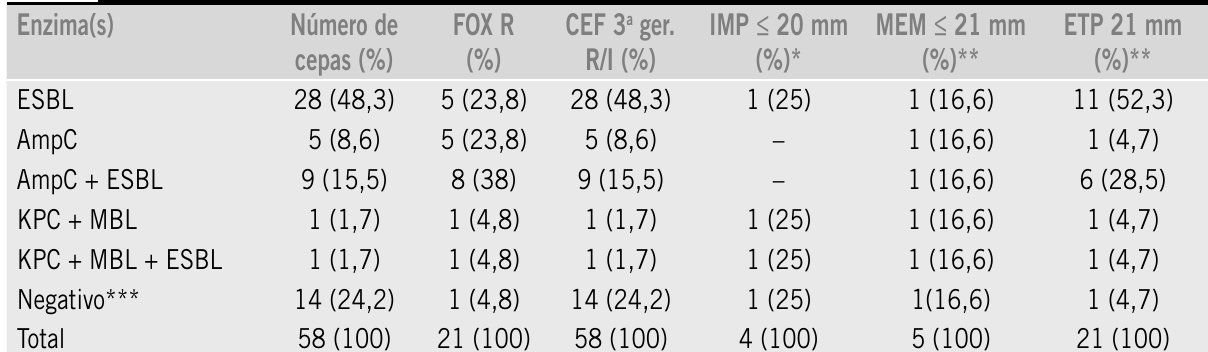
Enzimas betalactamases e perfil de sensibilidade aos antimicrobianos cefoxitina, cefalosporinas de terceira geração e